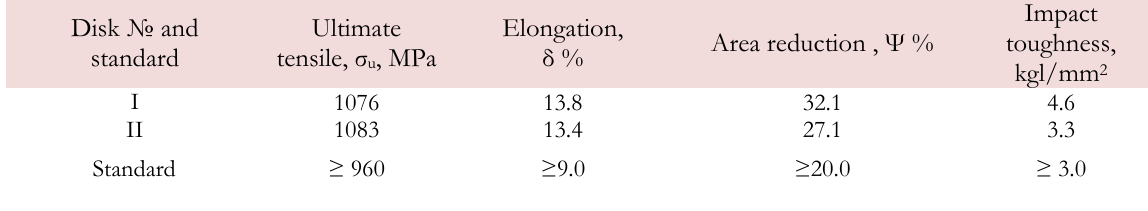
Table 1. Mechanical properties of two titanium disks of VT3-1 alloy at 20 o C.